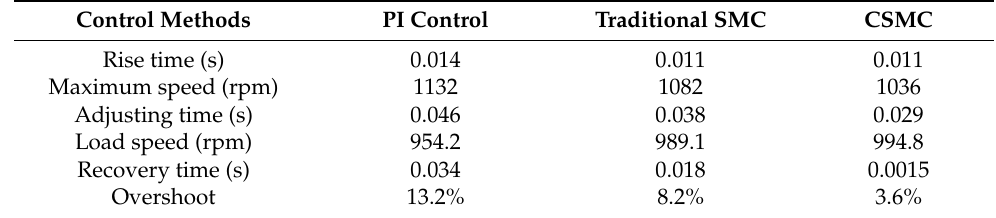
Table 3. Simulation speed changes and adjustment time under load